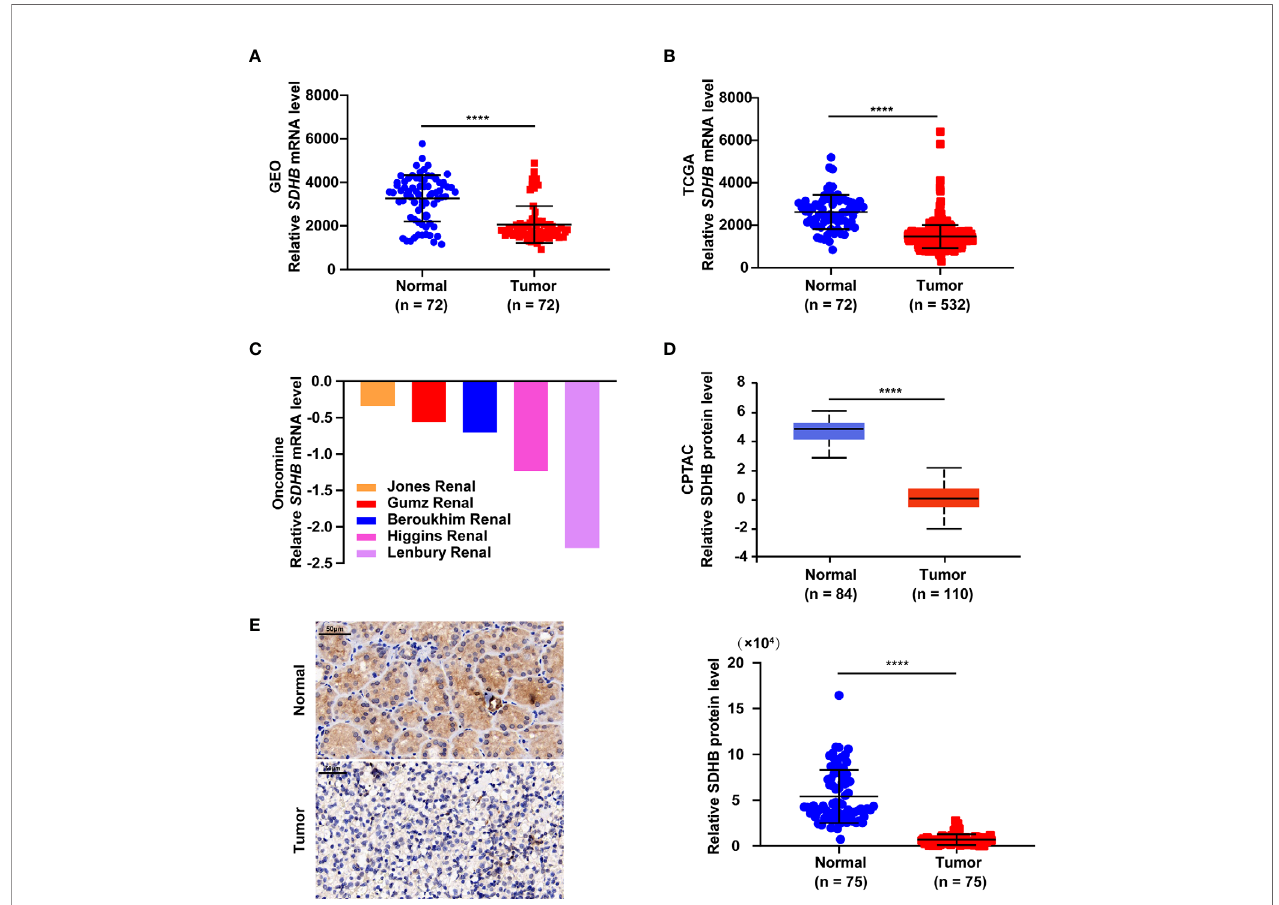
FIGURE 1 | SDHB expression level is downregulated in ccRCC tissues. (A – C) Comparison of SDHB mRNA levels between adjacent normal tissues and ccRCC tissues based on GEO GSE53757 data (A) , TCGA_KIRC data (B) , and oncomine data (C) , respectively. Oncomine data included Jones Renal (normal = 23; ccRCC = 32), Higgins Renal (normal = 3; ccRCC = 36), Beroukhim Renal (normal = 11; ccRCC = 32), Gumz Renal (normal = 10; ccRCC = 10), Lenbury kidney (normal = 9; ccRCC = 9). (D) Comparison of SDHB protein levels between adjacent normal tissues and ccRCC tissues based on CPTAC data. (E) Representative IHC fi gure of SDHB expression and scatter plot displaying the expression of SDHB in adjacent normal tissues and ccRCC tissues. P value was derived from independent sample two tailed t -test. The data were presented as mean ± SD. **** P <